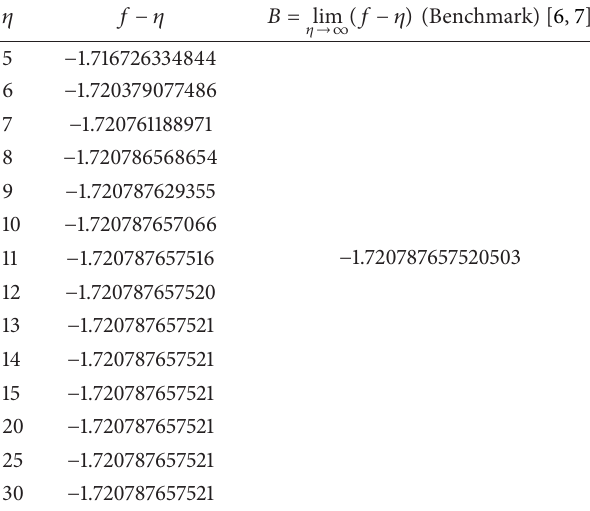
Table 5: The asymptotic property of 𝑓 for large positive 𝜂 ( 𝜆 = 1/5 , 𝑛 = 800